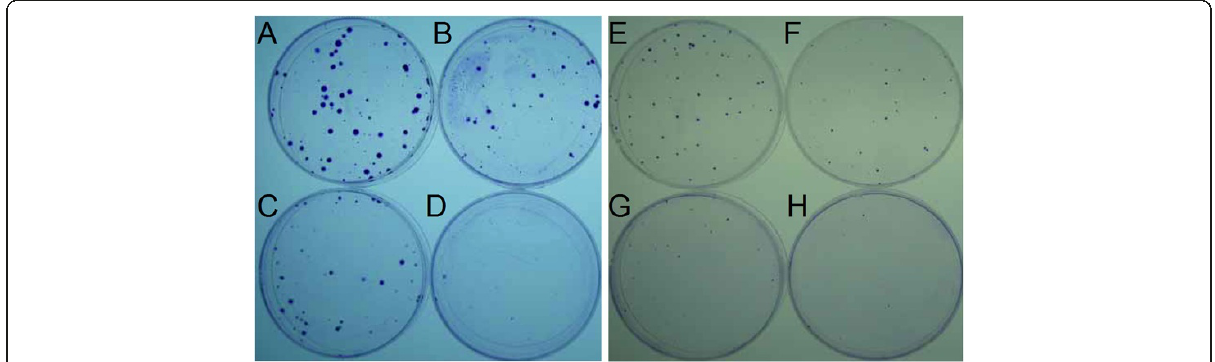
Figure 4 Effect of P. indica root crude aqueous extract on the focus formation ability of cancer cells. Focus formation assay of ( A , B , C , D ) GBM8401 cells and ( E , F , G , H ) HeLa cells after P. indica root aqueous extract treatment. ( A , E ) 0 μ g/ml P. indica root aqueous extract treatment. ( B , F ) 10 μ g/ml P. indica root aqueous extract treatment. ( C , G ) 100 μ g/ml P. indica root aqueous extract treatment. ( D , H ) 200 μ g/ml P. indica root aqueous extract treatment. Each experiment was repeated five times.